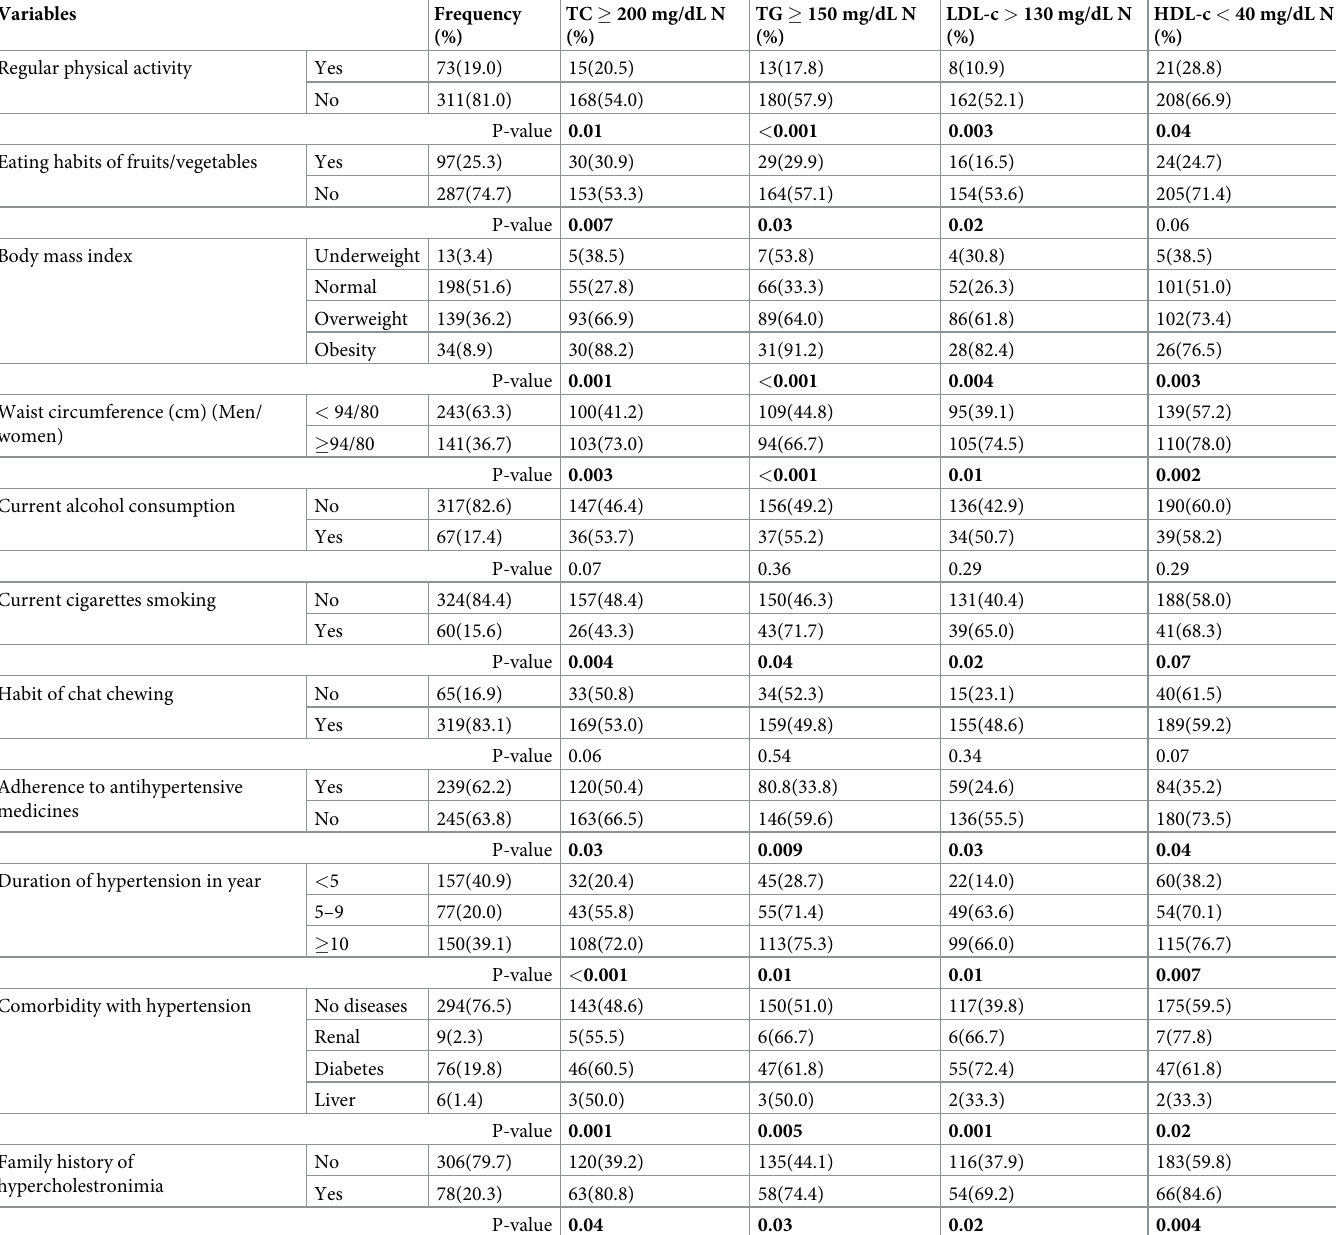
Table 2. Distribution of dyslipidemia by behavioural and lifestyle characteristics and other medical profiles of hypertensive patients in Northeast Ethiopia, 2021 (n = 384).